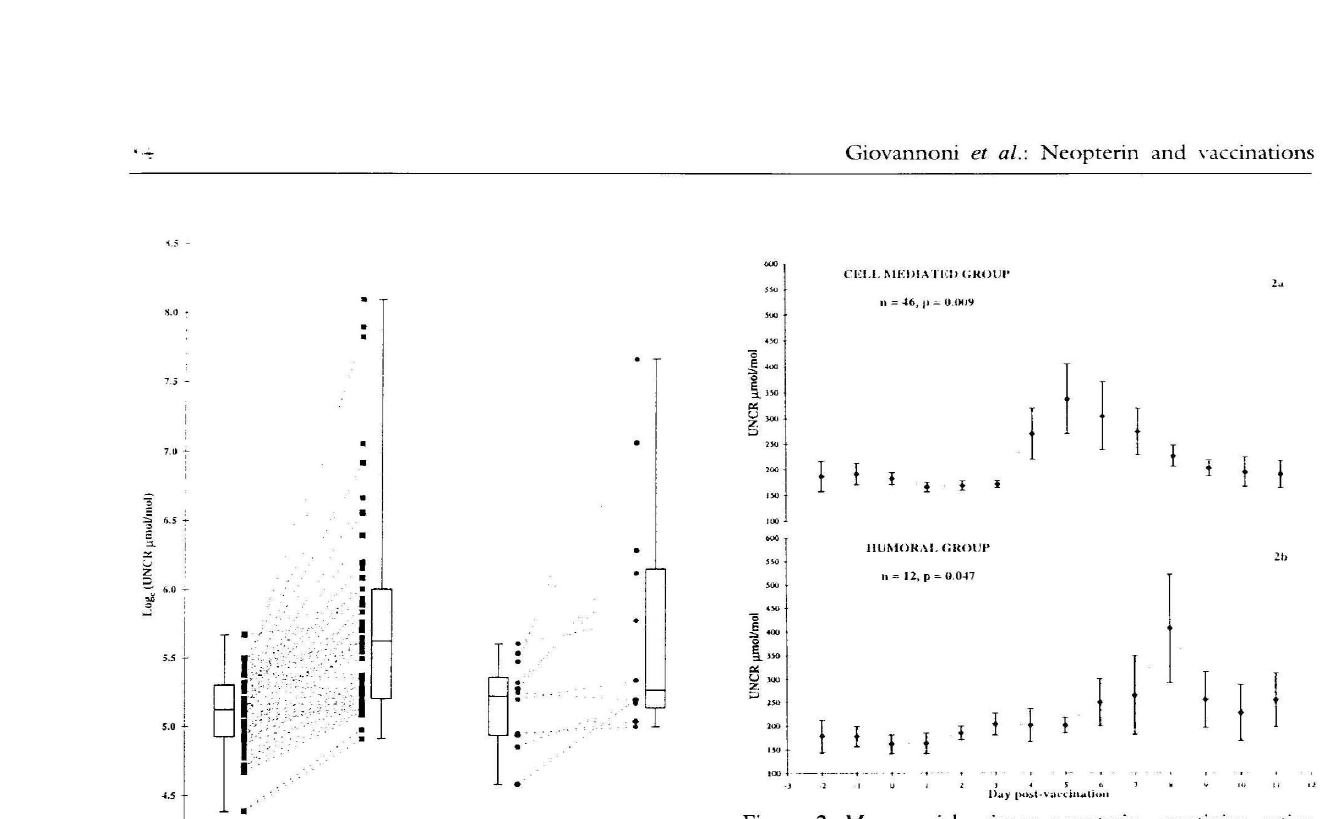
Figure 2. Mean serial urinary neopterin: creatinine ratios (UNCRs) of 46 subjects in the cell mediated (figure 2a), and 12 subjects in the humoral froup (figure 2b). All vac cinations or skin tests were administered on day. O. Data is presented as the mean ± standard error of the mean. and 2b respectively. In the eMI group a clear peak occurred between days 4 and 10, with the from days 2 pre-to day 3 post-vaccination (p =